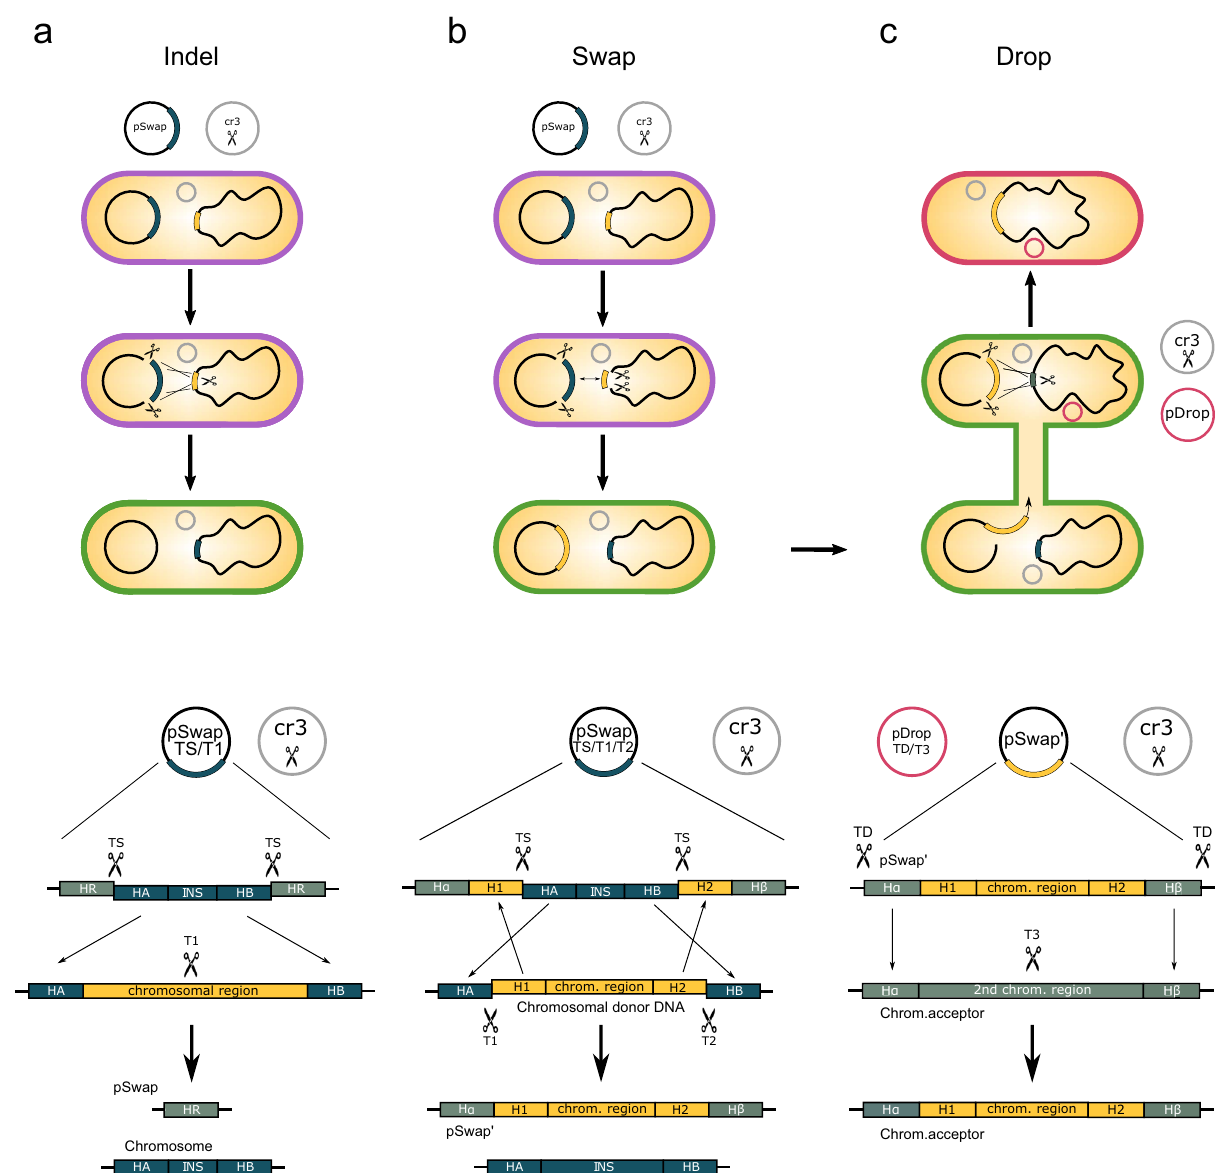
Fig. 1 Overview and mechanism of CRISPR SWAPnDROP. CRISPR SWAPnDROP is a genome editing system based on CRISPR/Cas9 counter-selection, homologous recombination and a multi-colour scarless co-selection. It facilitates scarless insertions and deletions (Indel) ( a ) and is capable of transferring chromosomal DNA between organisms ( b , c ). The pSwap plasmid harbours the template for homologous recombination including the homologous regions (HA, HB, HR, H1 α , H2 β ) and the insert DNA (INS), the sgRNA (TS) expression cassettes for the excision of the double-stranded donor template and for the chromosomal counter-selection (T1, T2). The excision is catalysed by CRISPR/Cas9 (Scissors), expressed from the helper plasmid cr3 together with the genes for ef fi cient homologous recombination. For the transfer of chromosomal regions, chromosomal donor DNA (yellow) is additionally excised (T1, T2). The two regions are swapped resulting in a pSwap plasmid loaded with a chromosomal region of interest (pSwap'). The loaded pSwap' plasmid can then be conjugated to a cell harbouring cr3 and the second helper plasmid pDrop, which catalyses the excision of the donor DNA on pSwap' (TD) and the subsequent integration into the acceptor chromosome via counter-selection (T3). Cell border colour represents the multi-colour co-selection system. Cells change their colour from purple to green and from green to red after the Indel/Swap and Drop events,